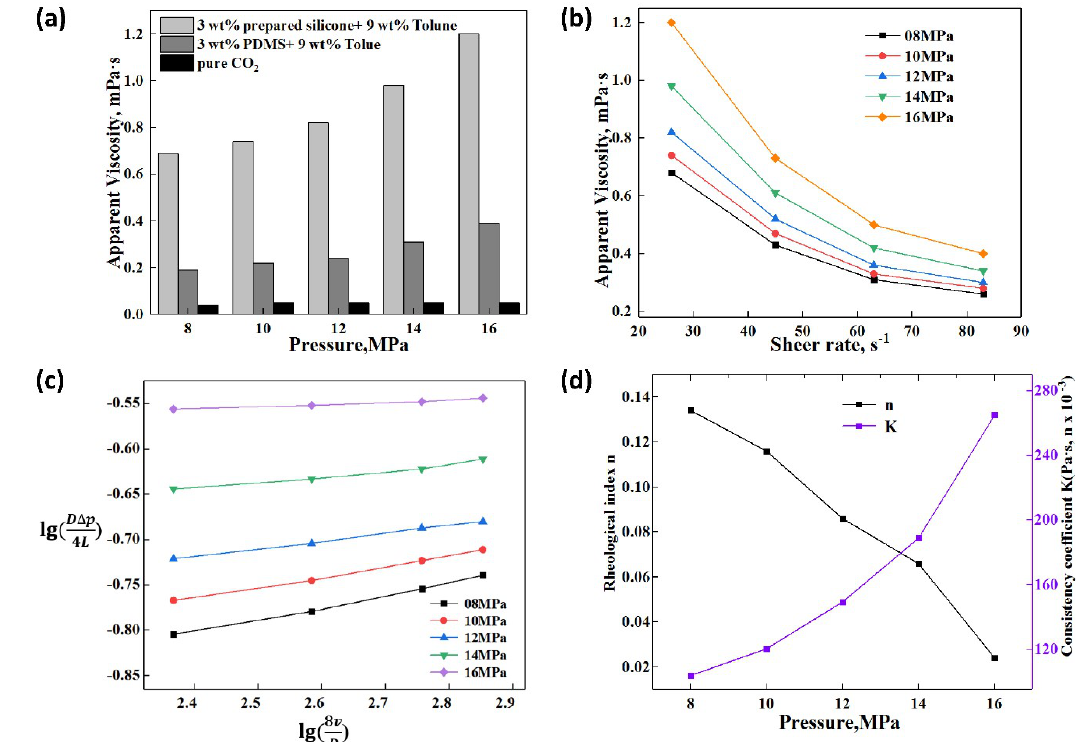
Figure 5. Effect of pressure on the apparent viscosity and rheology. ( a ) Temperature and apparent viscosity; ( b ) Shear rate and apparent viscosity; ( c ) Log τ w and Log(8 v / D ); ( d ) Rheological index, consistency coefficient and